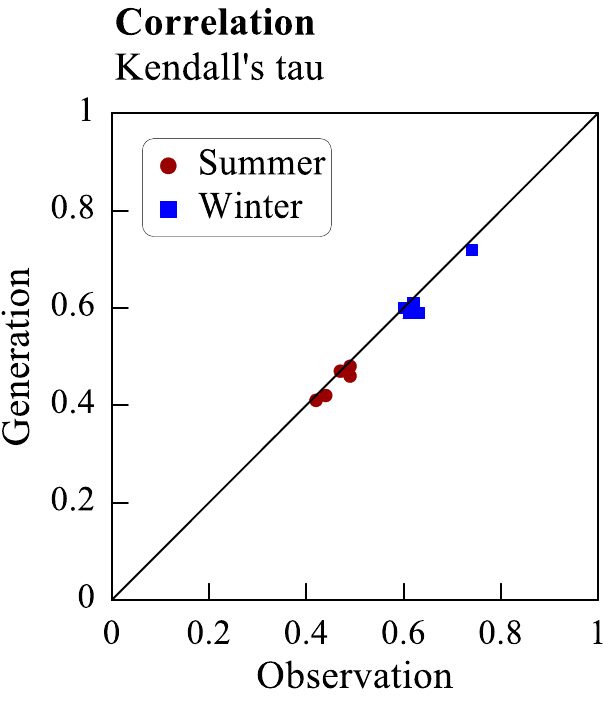
Figure 12. Comparison of the observed and generated correlations between rainfall quantity and duration.